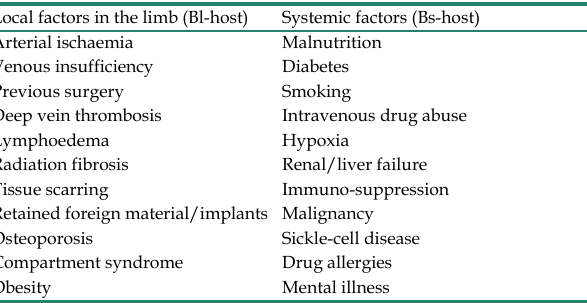
Table 2: Conditions associated with a compromised host status in the treatment of osteomyelitis.